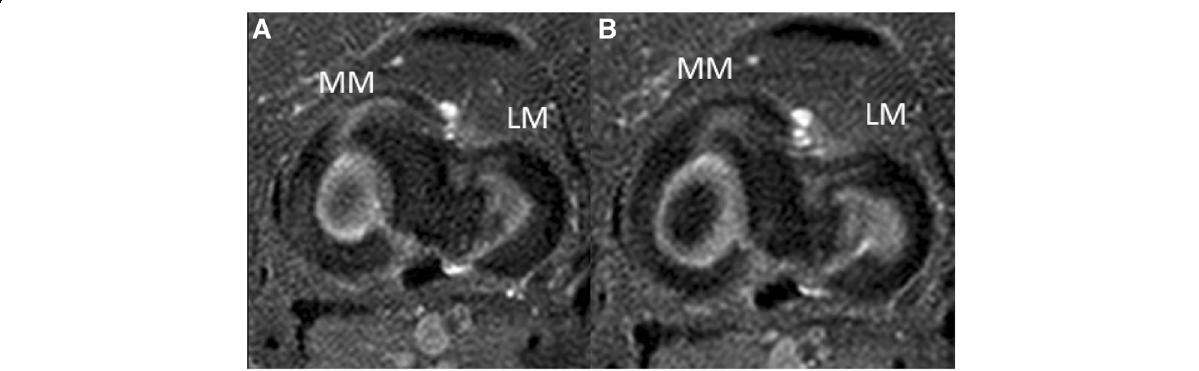
Fig. 1 a , b Two consecutive thin (0.5mm) axial PD fat-saturated images revealed normal meniscal configuration. MM=medial meniscus and LM=lateral